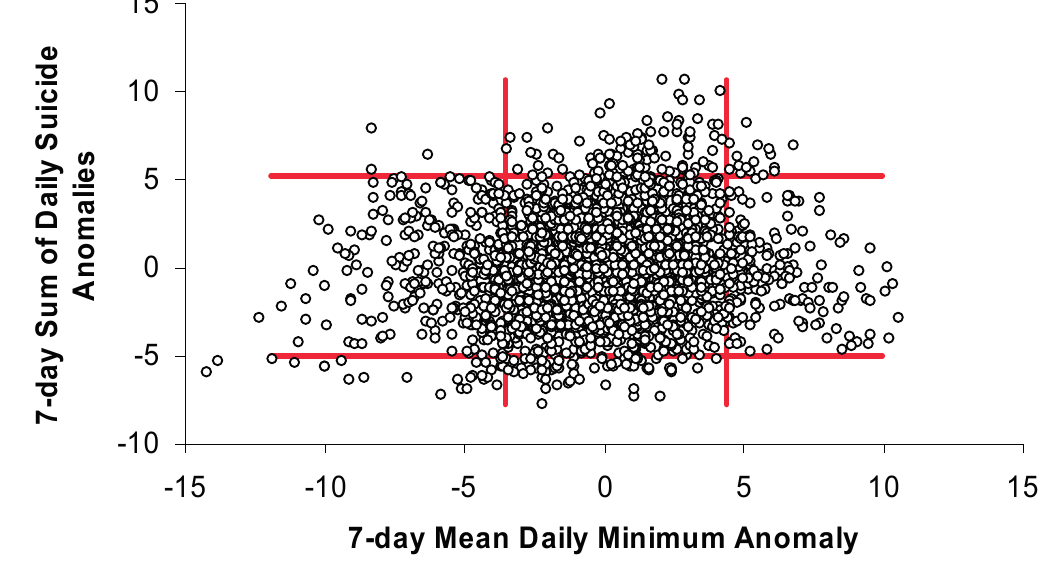
Figure 4. Weekly suicide anomalies plotted against weekly anomalies of daily minimum temperature for selected months (Jan, Jul, Aug, Sep) in Toronto. Red bars help to identify temperature-anomaly thresholds that may improve prediction of suicide